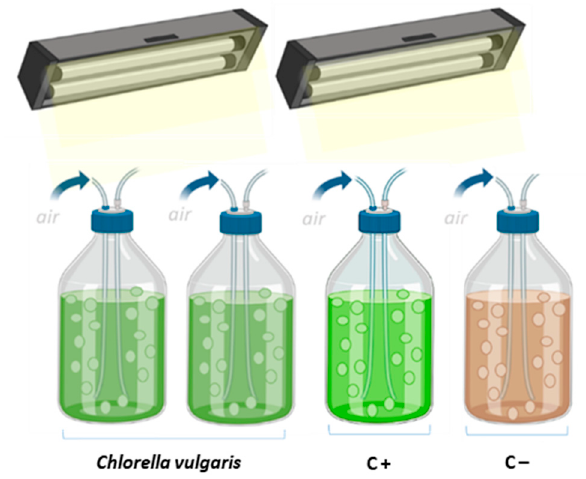
Figure 1. Experimental setup of the microalgal treatment, including the CV ( C. vulgaris + UWW) PBR, positive (C+, C. vulgaris + autoclaved UWW), and negative (C − , UWW) PBRs